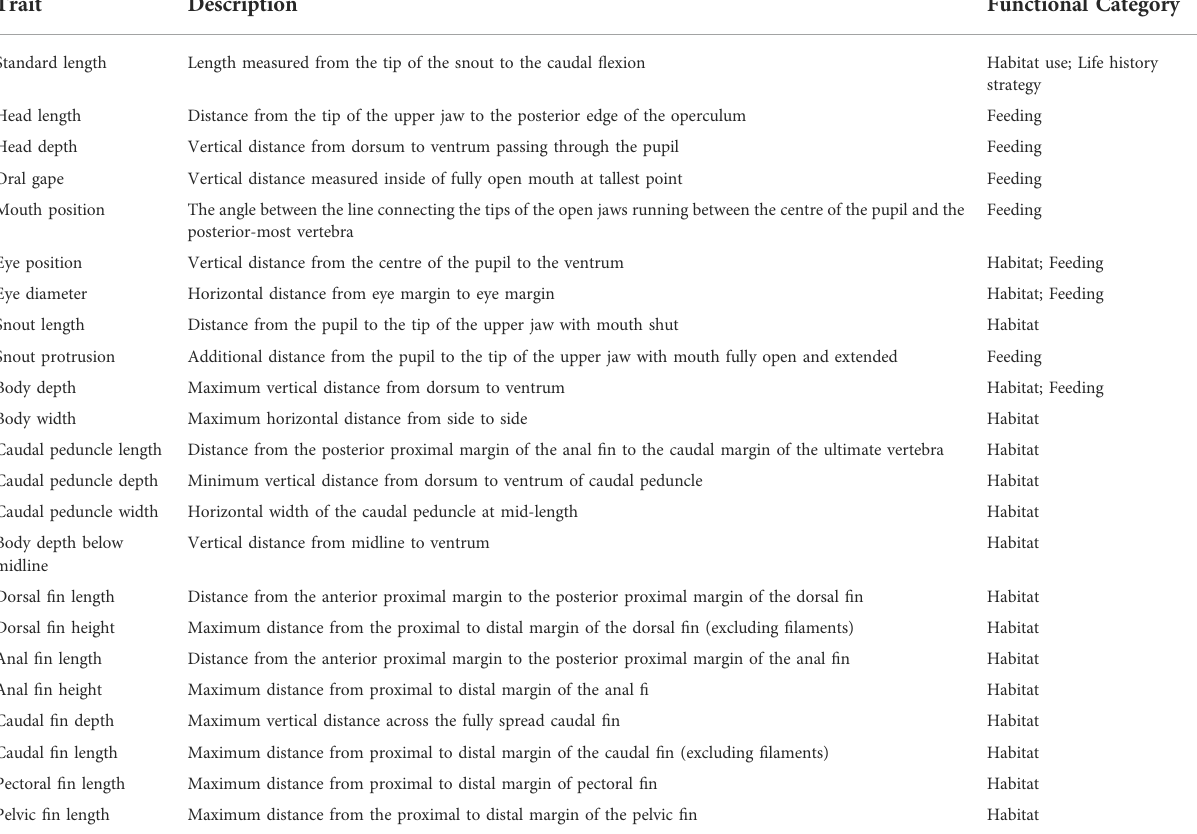
TABLE 2 Functionaltraits used for upper and lowerbasin fi sh assemblages with description of measurement from Pease et al.(2012). Traitde fi nitions and functional categories follow (Gatz, 1979; Webb, 1984; Winemiller, 1991; Winemiller and Rose, 1992; Sibbing and Nagelkerke, 2000).